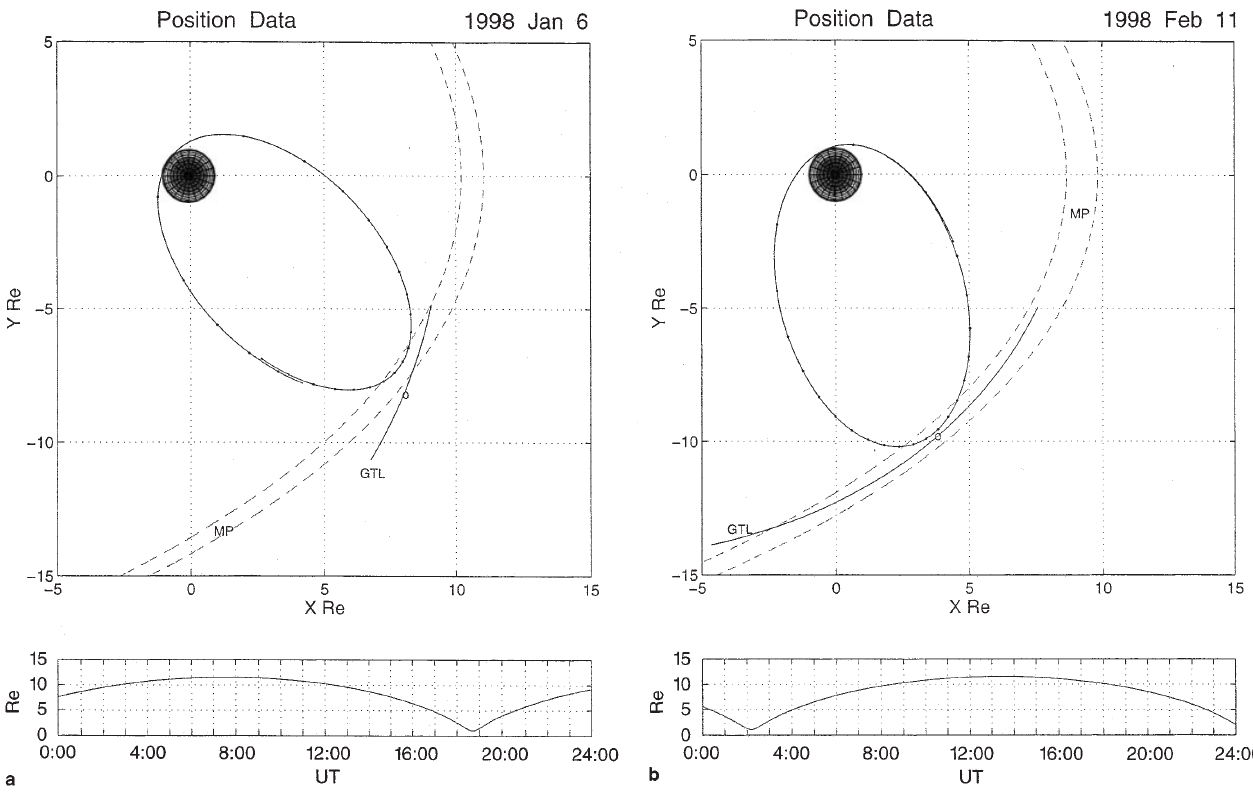
Fig. 10a, b. Geotail orbit segments and Equator-S for the time of the two conjunctions described in Sect. 3.4. The cuts through the relevant model magnetopause surfaces at the Equator-S crossings and in the X , Y plane are shown, together with the Geotail position at the time of